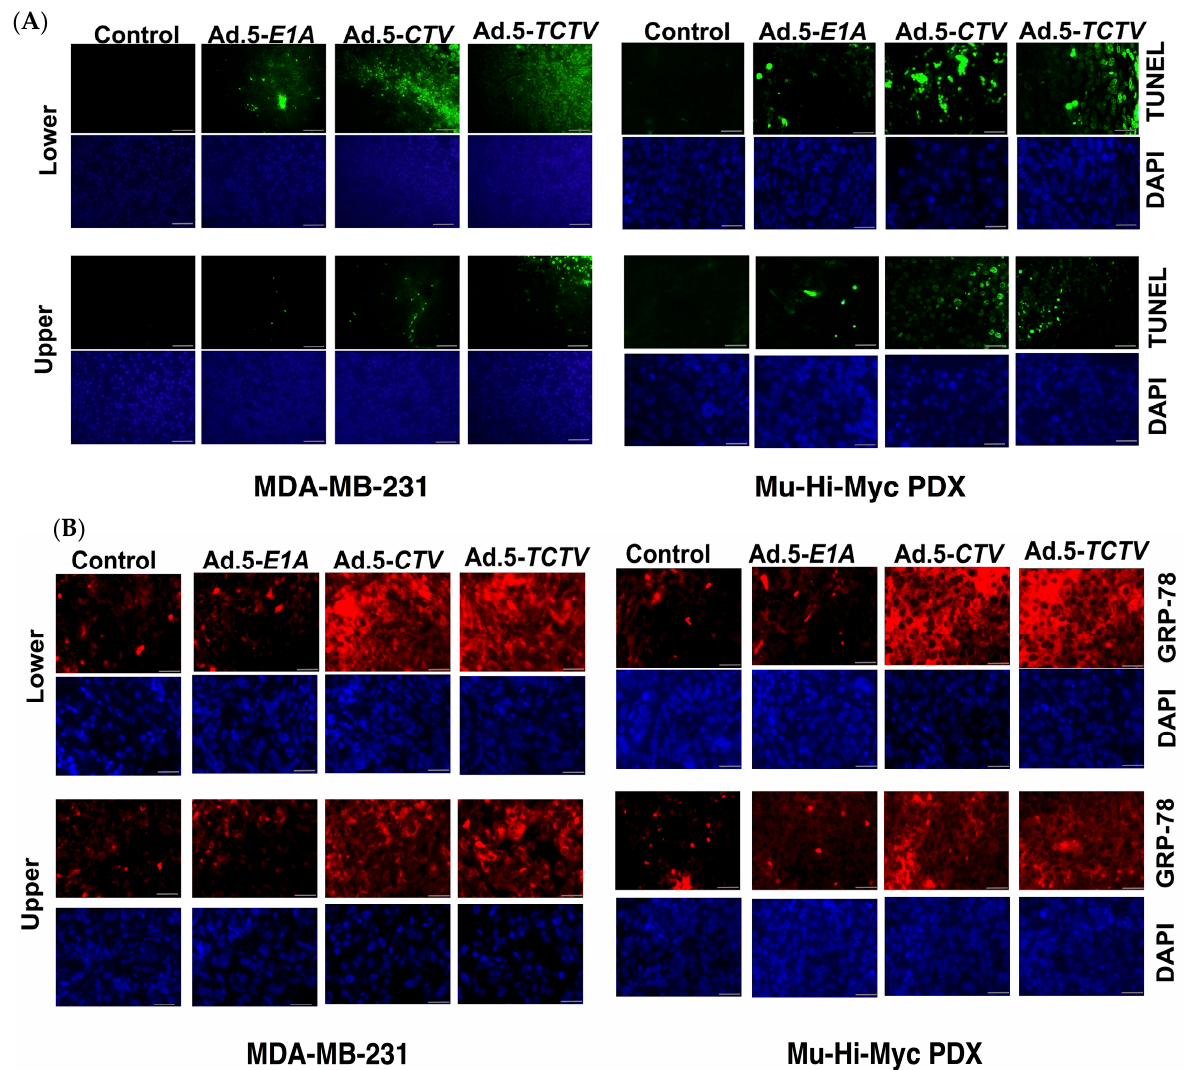
Figure 8. Ad.5- CTV and Ad.5- TCTV induces ER stress (GRP-78) and apoptosis (TUNEL) in breast and prostate tumors in nude mice. ( A ) MDA-MB 231 and mu-Hi-Myc PDX cancer cells were implanted subcutaneously in the lower and upper flanks of nude mice and lower tumors were infected with the indicated virus. A total of five animals were studied in each group. Once the control animals’ tumors reached maximum allowable limit, tumors were collected fixed in formalin and embedded in paraffin. TUNEL assays were performed according to the manufacturers protocol. Nuclei were stained with DAPI. Photographs were taken in ten random microscopic fields and representative pictures are shown. ( B ) Formalin and embedded in paraffin samples as prepared in A above, were stained for GRP-78 (an ER stress marker) and nuclei were stained with DAPI. Scale bar: 50 μ M.